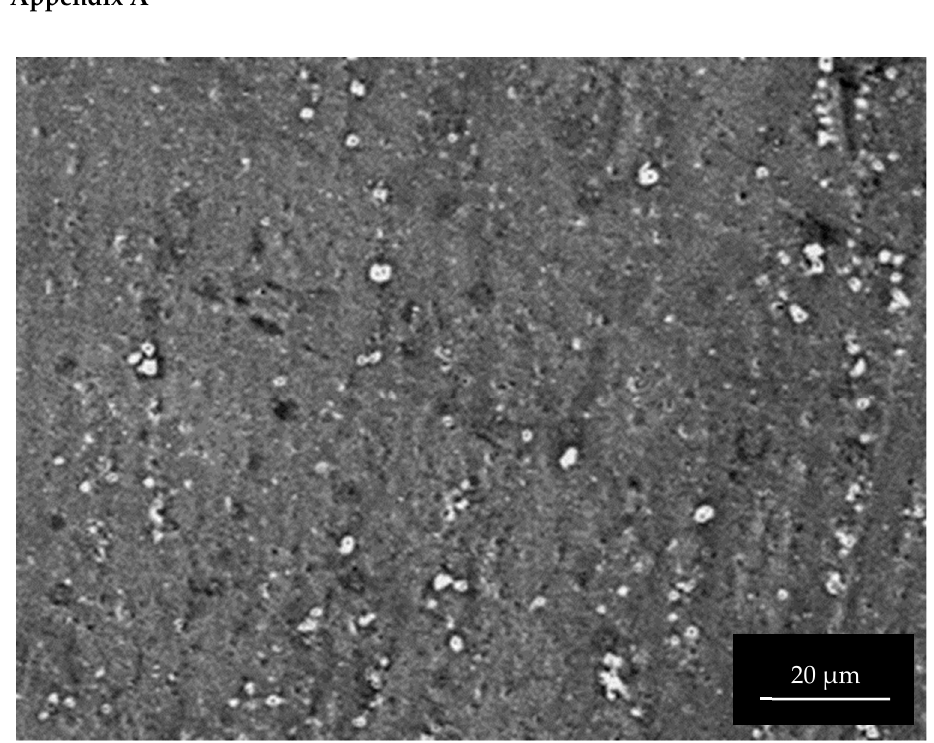
Figure A1. Surface of 3003-Al alloy with t a = 0. Figure 2c was enlarged to 500%.